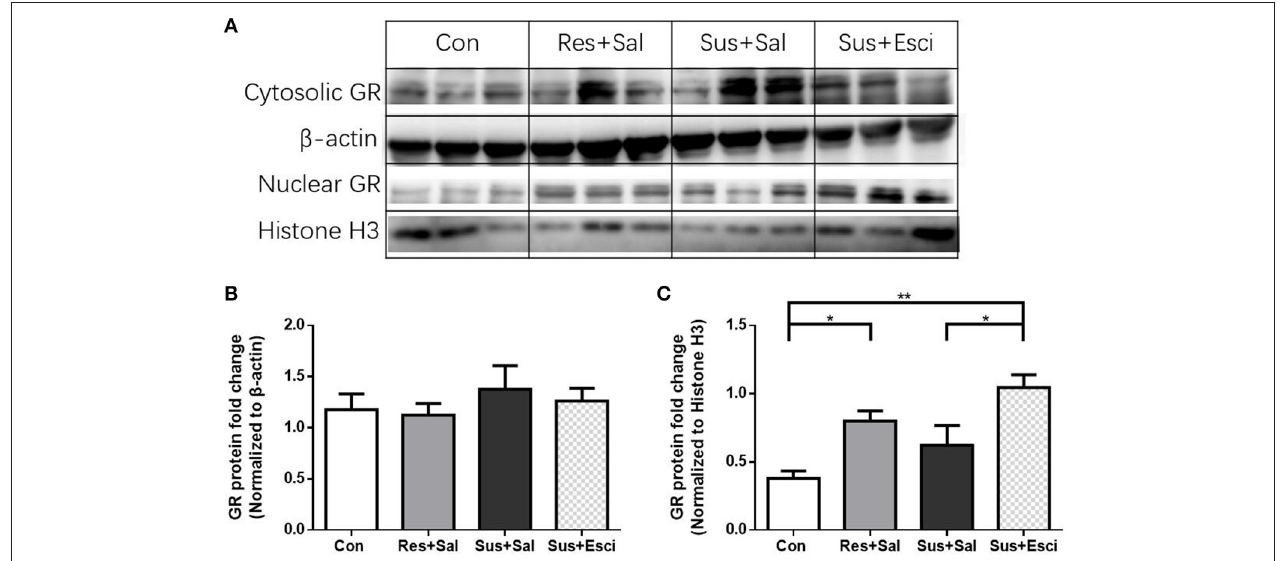
FIGURE 8 | Escitalopram could increase nuclear translocation of GR in hippocampus of susceptible mice. (A) Representative western blots showing cytosolic and nuclear protein expression of GR. (B) Quantification of cytosolic protein expression of GR in the hippocampus after 4 weeks treatment ( n = 4/group). (C) Quantification of nuclear protein expression of GR in the hippocampus after 4 weeks treatment ( n = 4/group). All data are shown as mean ± s.e.m. * P < 0.05, ** P < 0.01. Con, Control; Res + Sal, Resilient + Saline; Sus + Sal, Susceptible + Saline; Sus + Esci, Susceptible +